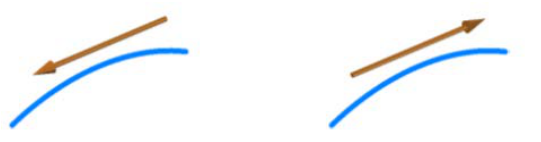
Figure 17: The two inner orientations of a curve.